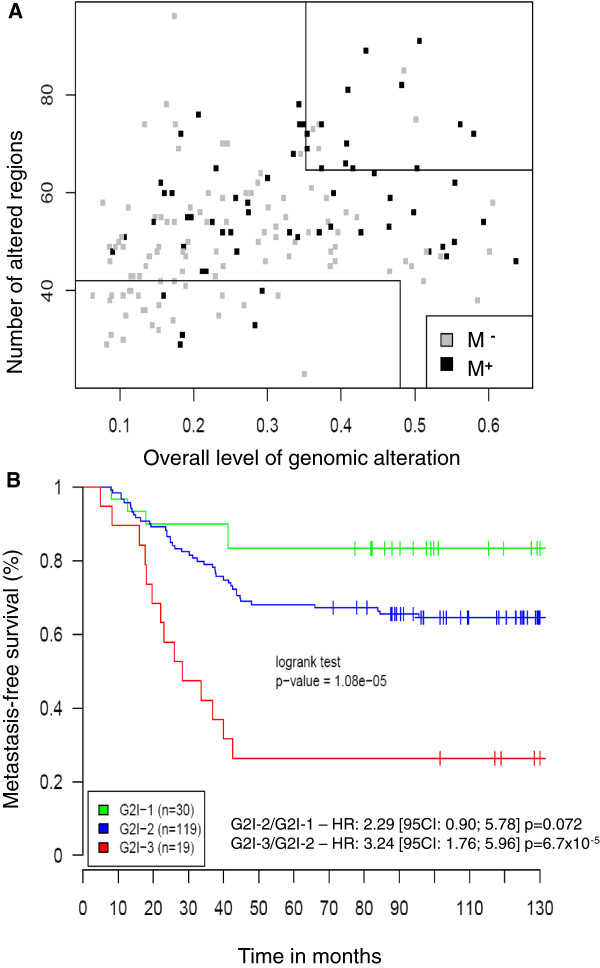
Prognostic value of the G2I on independent data set. (A) Scatter plot of 168 breast cancers from which BAC array CGH data were available [21] according to the two items and the previously defined thresholds of the G2I. M+: metastatic relapse; M-: absence of local or metastatic relapses after five years of follow-up. (B): Kaplan Meier curves showing metastasis-free survival at 10 years for the three G2I classes. Green: G2I-1, blue: G2I-2, red: G2I3; the number of tumors in each G2I class is given in parenthesis. HR: hazard ratio (log-rank test).